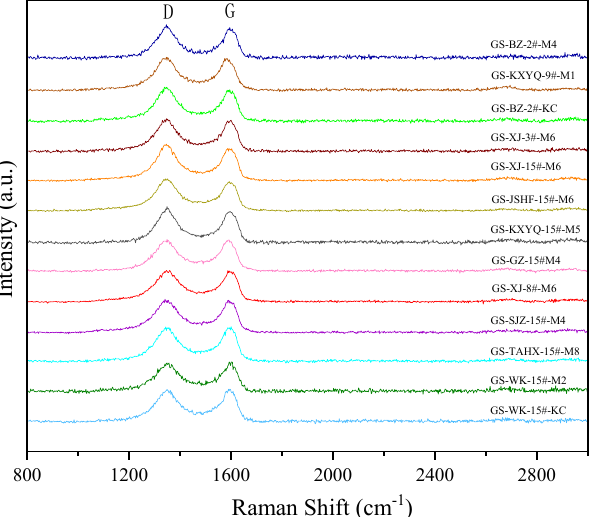
Table 7. Raman parameters of coal-based graphite.